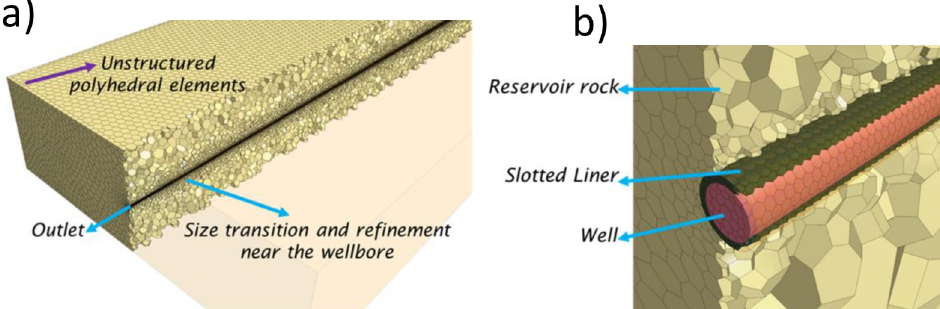
Fig 5. Representation of the mesh used in this study, a) general view, b) focus on the well and liner regions.